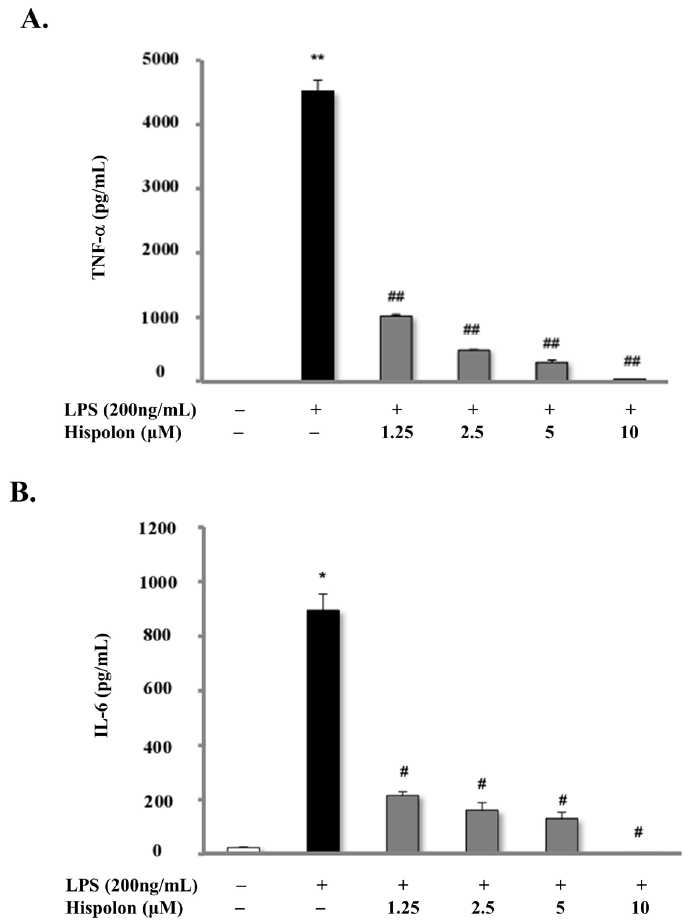
Figure 3. Hispolon suppressed TNF- α and IL-6 production in LPS-induced RAW264.7 cells. ( A , B ) Cells were preincubated with 2.5, 5, or 10 µ M hispolon for 1 h and then treated with 200 ng/mL LPS for 12 h. Subsequently, TNF- α and IL-6 levels in the culture media were measured using ELISA kits. Dexamethasone (Dexa) was used as a positive control. The data are presented as the means of three separate experiments performed in triplicate ( n = 3). Significance was analyzed using one-way ANOVA; * p < 0.05 and ** p < 0.01, vs. control group; # p < 0.05 and ## p < 0.01, vs. LPS-treated group.